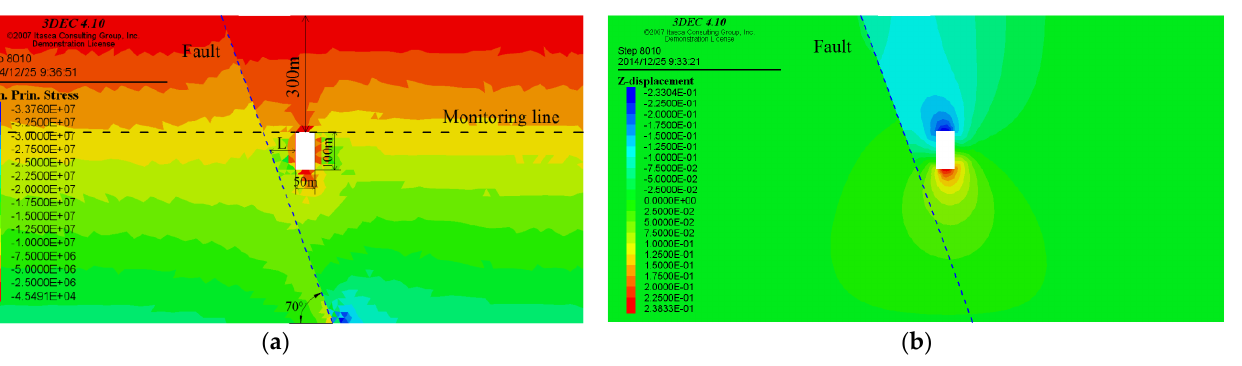
Figure 1. Nephogram of stress and displacement distribution of surrounding rock when the mining area is 60 m away from the fault hanging wall, they should be listed as: ( a ) Maximum principal stress nephogram; ( b ) Vertical displacement nephogram.